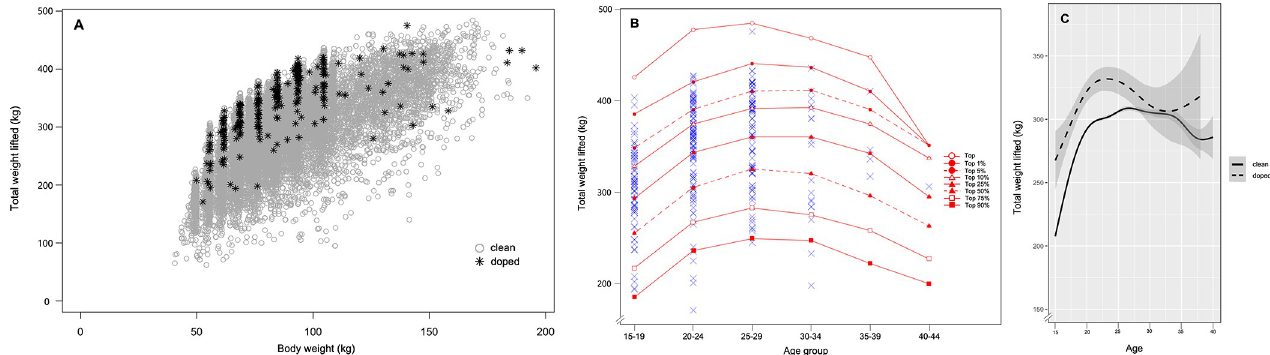
Fig 2. Male weightlifters’ performance in total weight lifted (kg) across age (26,740 results of not-sanctioned, 289 results of sanctioned). (A) Scatter plot showing the overall performance distribution for all athletes. Gray open circles represent results of not-sanctioned athletes, and black asterisks represent results of sanctioned athletes. (B) Age group analysis of performance (total weight lifted, kg) by age group for male weightlifters. Solid line with open circles represents performance of the top athlete, solid line with filled circles represents athletes in the top 1%, dashed line with filled circles represents athletes in the top 5%, solid line with open triangles represents athletes in the top 10%, solid line with filled triangles represents athletes in the top 25%, dashed line with filled triangles represents athletes in the top 50%, solid line with open squares represents athletes in the top 75%, and solid line with filled squares represents athletes in the top 90%. Blue X’s represent results of sanctioned athletes. (C) Line graph showing the trend of performance change. Solid line represents the mean of not- sanctioned athletes and dashed line represents the mean of sanctioned athletes, and shaded area indicates standard error.